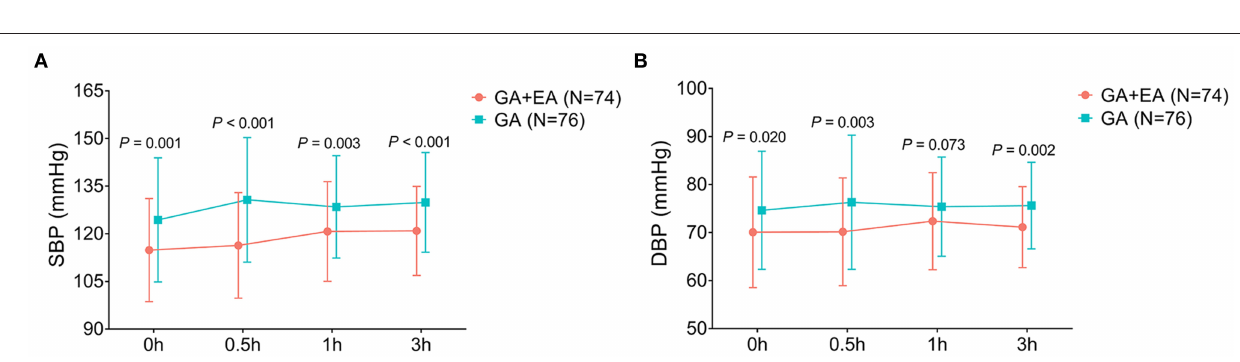
FIGURE 5 | SBP and DBP. Comparison of SBP (A) and DBP (B) between GA + EA group and GA group. GA, general anesthesia; EA, epidural anesthesia; SBP, systolic blood pressure; DBP, diastolic blood pressure; h,